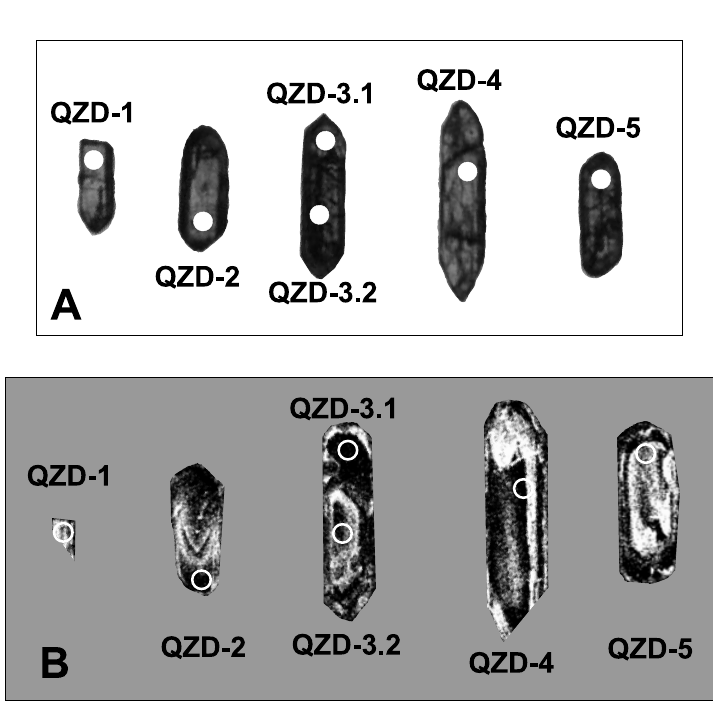
Fig. 5 – Microscope (A) and cathodoluminescense (B) images of zircon grains from sample CAWT02 (PC-18E – M-II facies) of Glória